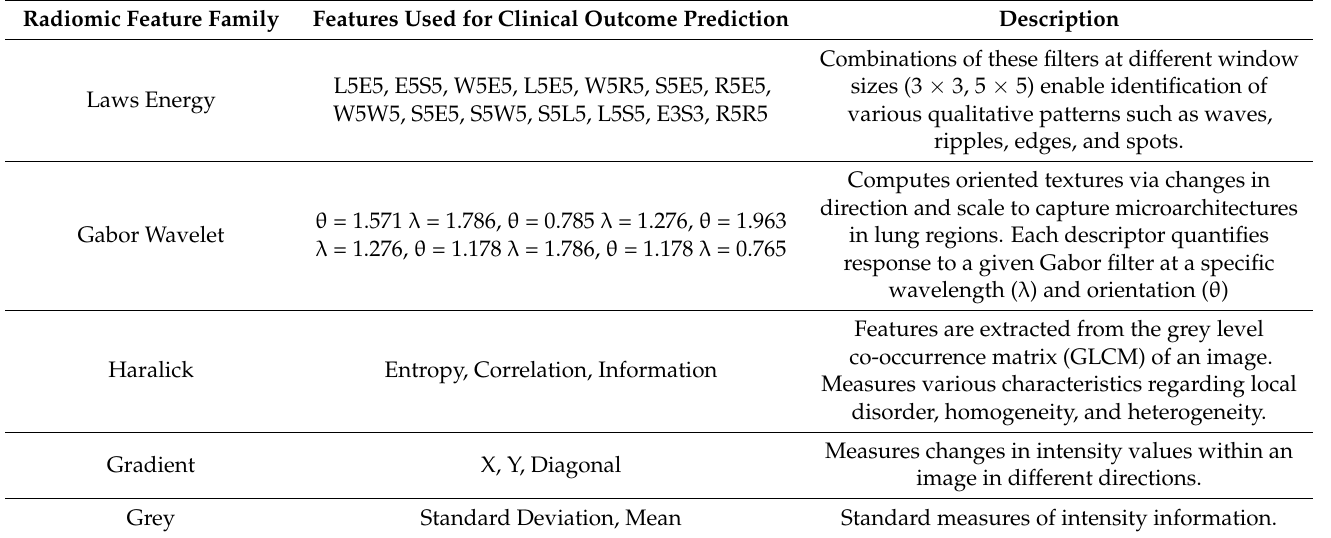
Table 3. Selected predictive radiomic feature